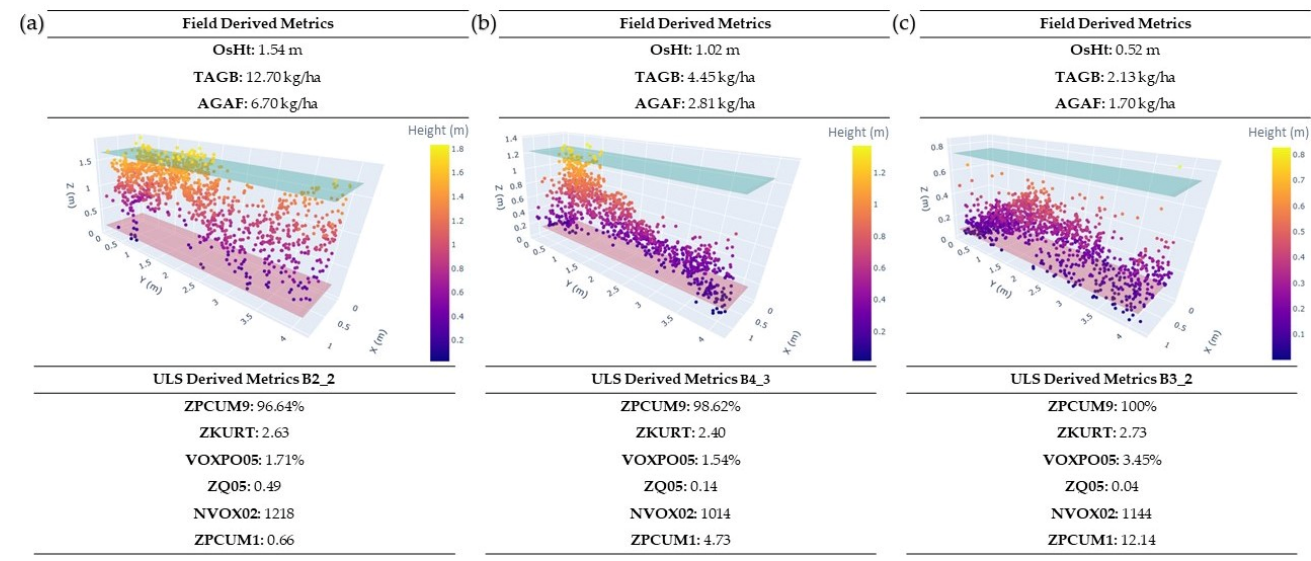
Figure 8. Height normalised ULS point cloud plots representing the range in physical metrics within the vegetation plots and the corresponding ULS structural metrics, showing ( a ) high, ( b ) medium and ( c ) low levels of OsHt, TAGB and AGAF. Variation in the independent variables included in the model are shown below the figure. Red and Green surfaces, respectively, represent the first and ninth height deciles, up to which the cumulative percentage of points are calculated to derive ZPCUM1 and ZPCUM9.